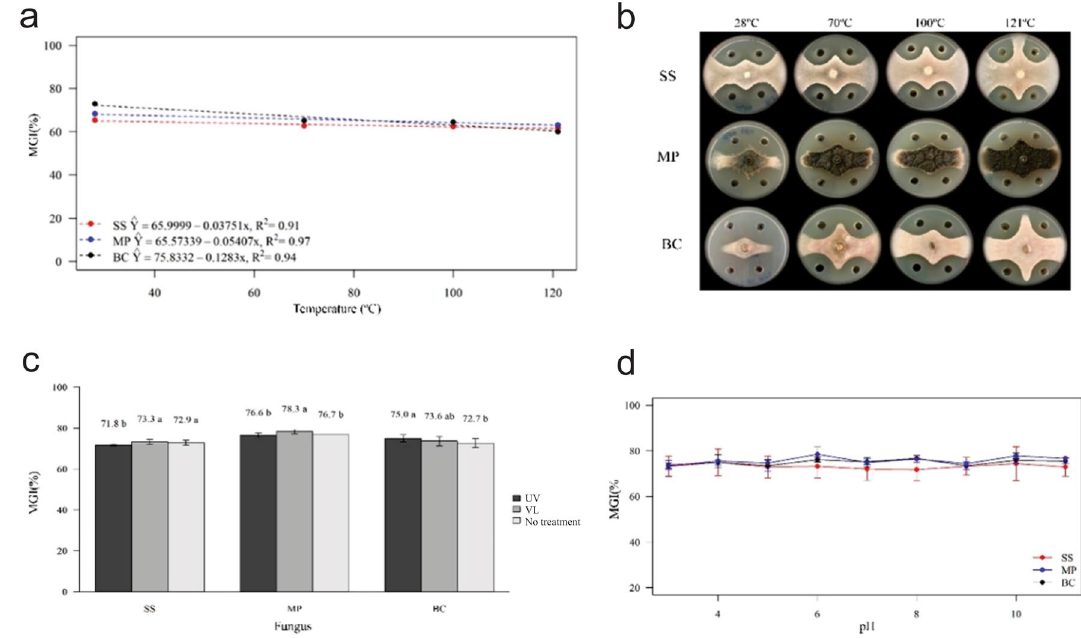
Figure 4. Mycelial growth inhibition (MGI%) of Sclerotinia sclerotiorum (SS), Macrophomina phaseolina (MP), and Botrytis cinerea (BC) by the cell-free supernatant (CFS) of Bacillus velezensis CMRP4489 after thermal, light, and pH treatments. ( a ) CFS stability at 28 °C (no treatment), 70 °C, 100 °C, and 121 °C. ( b ) Mycelial growth of SS, MP, and BC at different temperatures in the thermostability test. ( c ) CFS photostability assay in UV light (UV), at a wavelength of 365 nm, and visible light (VL). Same letters did not differ according to the Kruskal– Wallis test ( p < 0.05). ( d ) CFS stability at different levels of pH